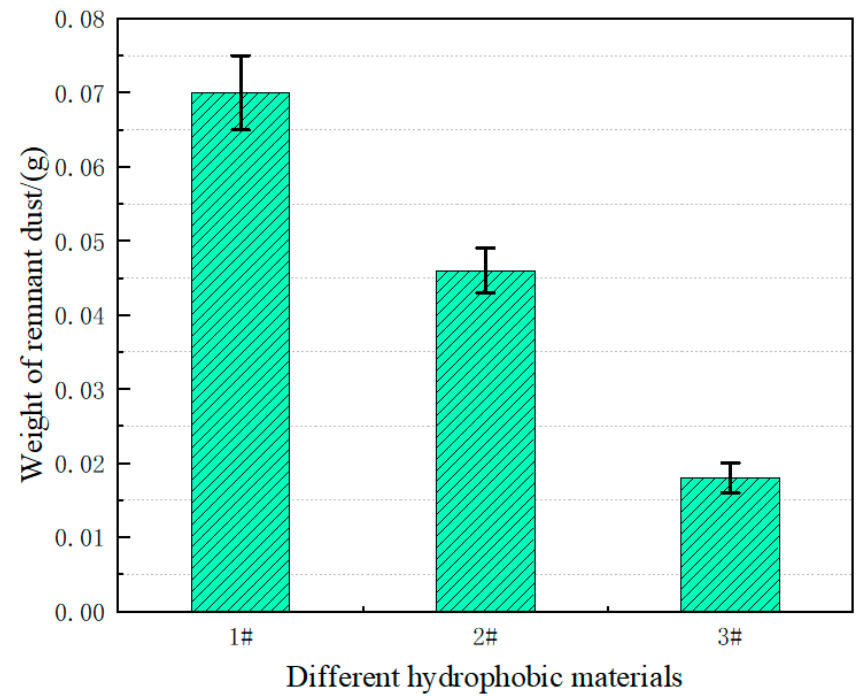
Figure 5. Residual dust weight of different specimens.